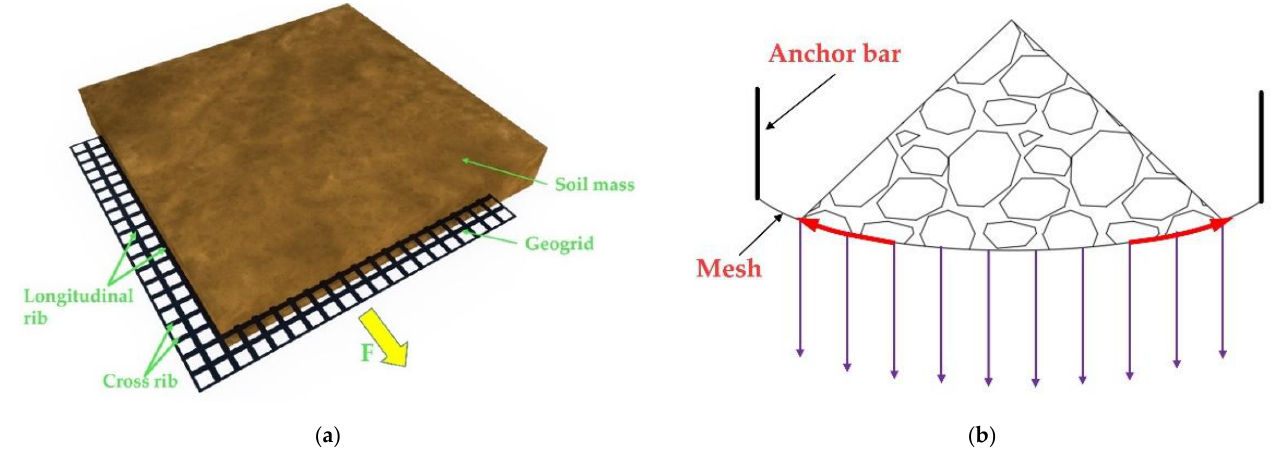
Figure 2. Mechanism of geogrid in different fields: ( a ) reinforcement field; ( b ) bolt mesh support- ing field